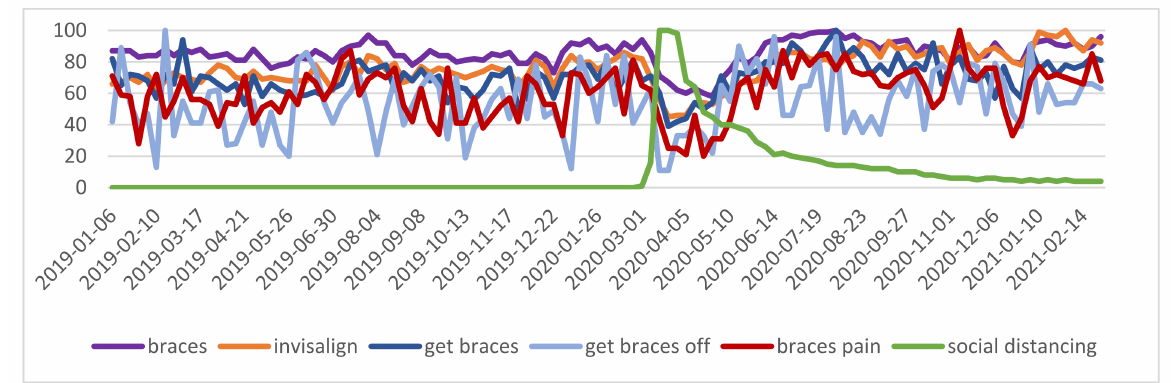
Figure 1. Worldwide phrases—relative search volume.